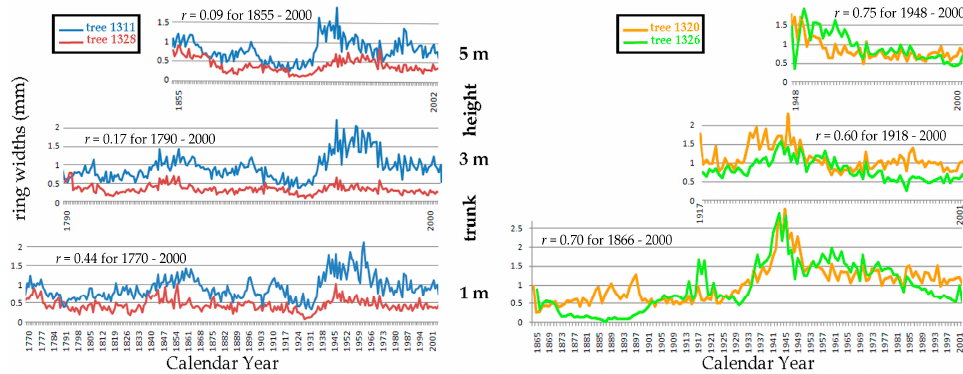
Figure 22. Between-tree correlations of gišogenetic vigour in chronologically corresponding radial series on the south side of each trunk at three trunk heights. The left panel compares tree 1311 with tree 1328, and the right panel compares tree 1320 with tree 1326.